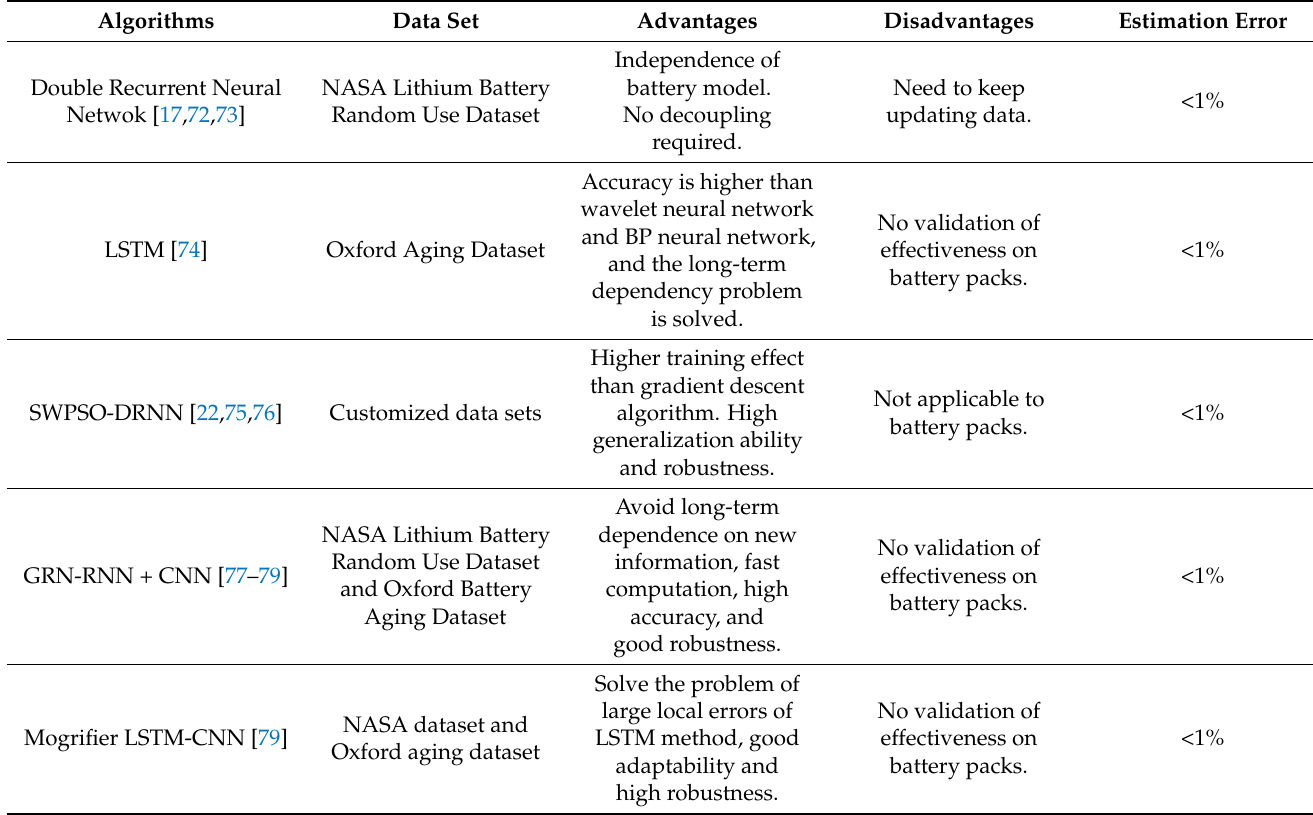
Table 7. Joint data-driven SOC/SOH-based estimation